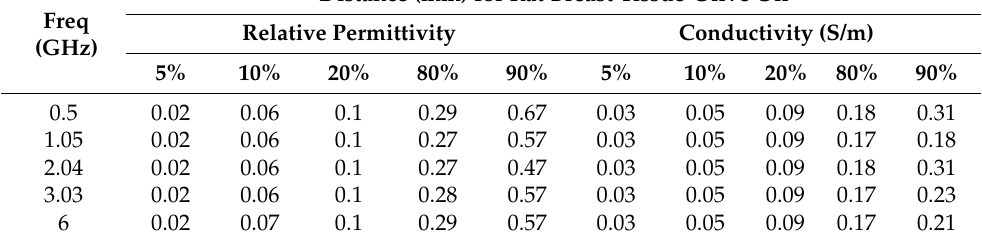
Table 6. Specified decrease levels for retrieved relative permittivity and conductivity of double- layered rat breast tissue and olive oil configuration and the corresponding distances (D n ) at 0.5, 1.05, 2.04, 3.03 and 6 GHz frequency points.